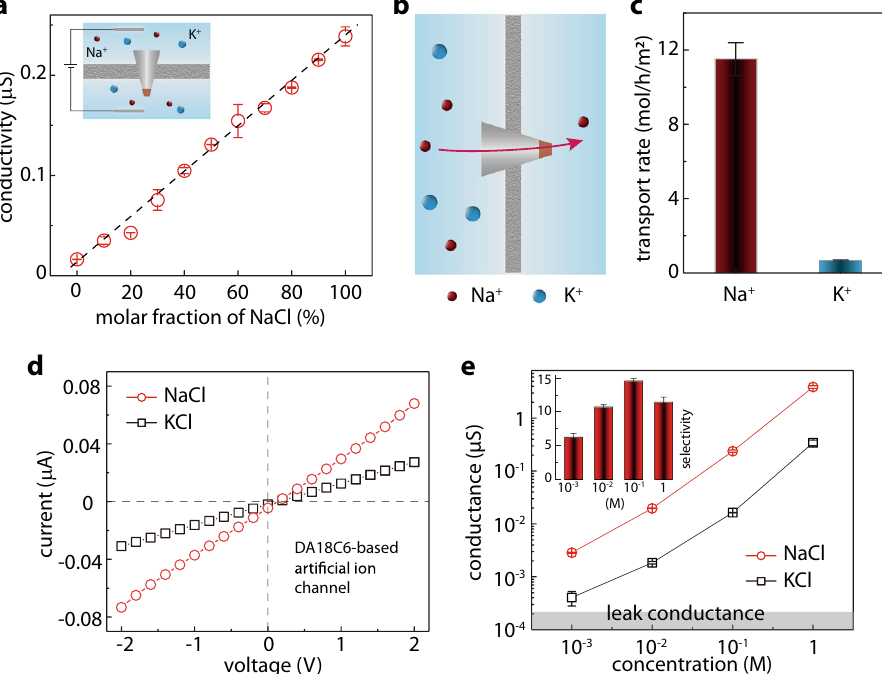
Fig. 4 Na + /K + selectivity of the arti fi cial sodium-selective ionic device. a Ionic conductance for NaCl + KCl mixture solutions with a total concentration of 0.1 M and variable NaCl molar ratios. The conductance increased almost linearly with the NaCl molar ratio, suggesting the reliable Na + /K + selectivity in the binary ion mixture. Inset: schematic illustration of the setup. To further con fi rm this, we conducted ion diffusion measurement. b Schematic illustration of the diffusion experiment setup. The feed side reservoir (left) contained 0.1 M NaCl + 0.1 M KCl, and the permeate side (right) contained ultrapure water. c The measured transport rate of Na + and K + . The calculated selectivity (~15) is also in agreement with the one extracted from ionic conductivity results. d To verify the important role of the porous crystal structure of the DA18C6-nitrate, we again tested the ion selectivity of the noncrystalline-DA18C6-based arti fi cial ion channel, which is merely ~2. e The conductance of the NaCl and KCl through the arti fi cial sodium-selective ionic device as a function of concentration. Inset: calculated selectivity. Error bars in all cases indicate the standard deviation of the